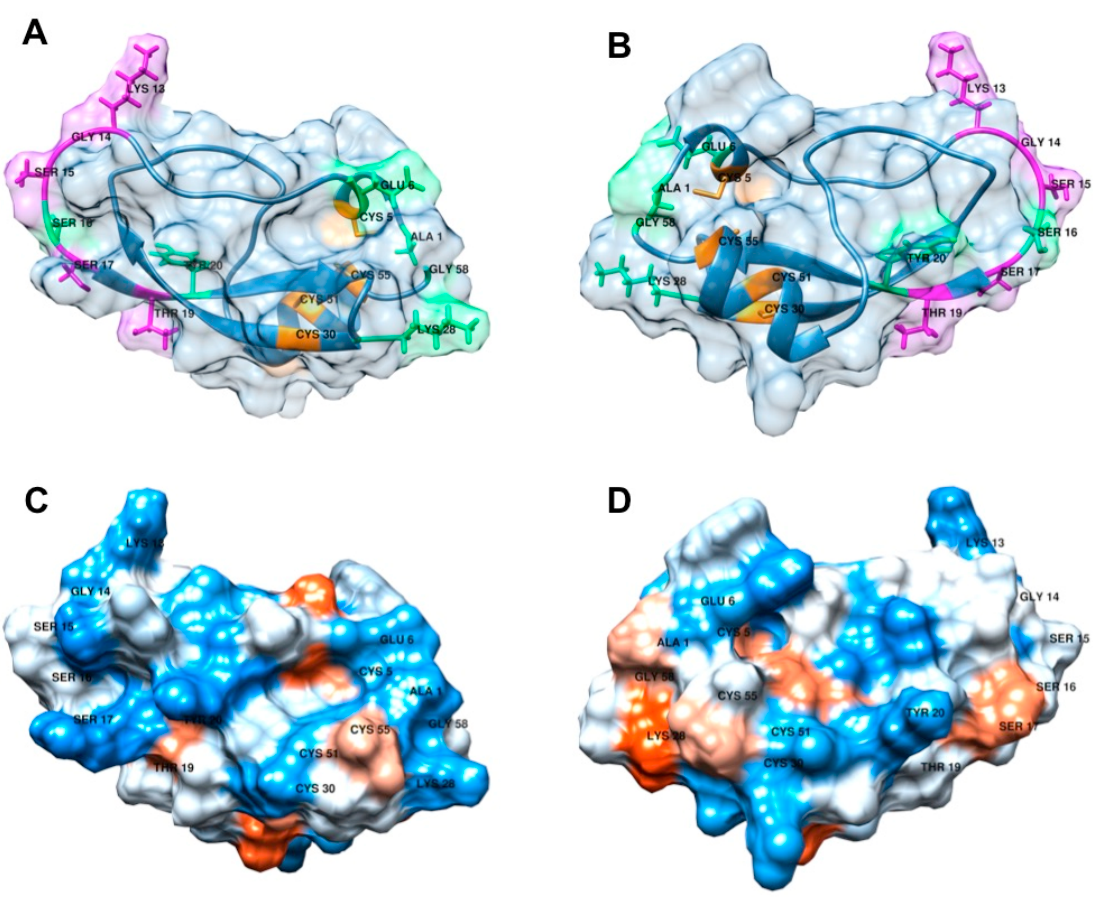
Figure 6. 3D model of arenin from D. arenicolor skin secretions. ( A ) Front and ( B ) back ribbon model of arenin, Unique amino acids Glu 6 Ser 16 Tyr 20 and Lys 28 are highlighted in green, amino acids Lys 13 Gly 14 Ser 15 Ser 16 Ser 17 Thr 19 possibly constitutes the trypsin interaction site ku and are highlighted in purple, amino acids Cys 5 -Cys 55 and Cys 30 -Cys 51 involved in the formation of disulfide bonds are highlighted in orange. ( C ) Front and ( D ) back polarity model prediction of arenin, blue zones represent polar residues, red zones non-polar residues and white zones neutral residues.